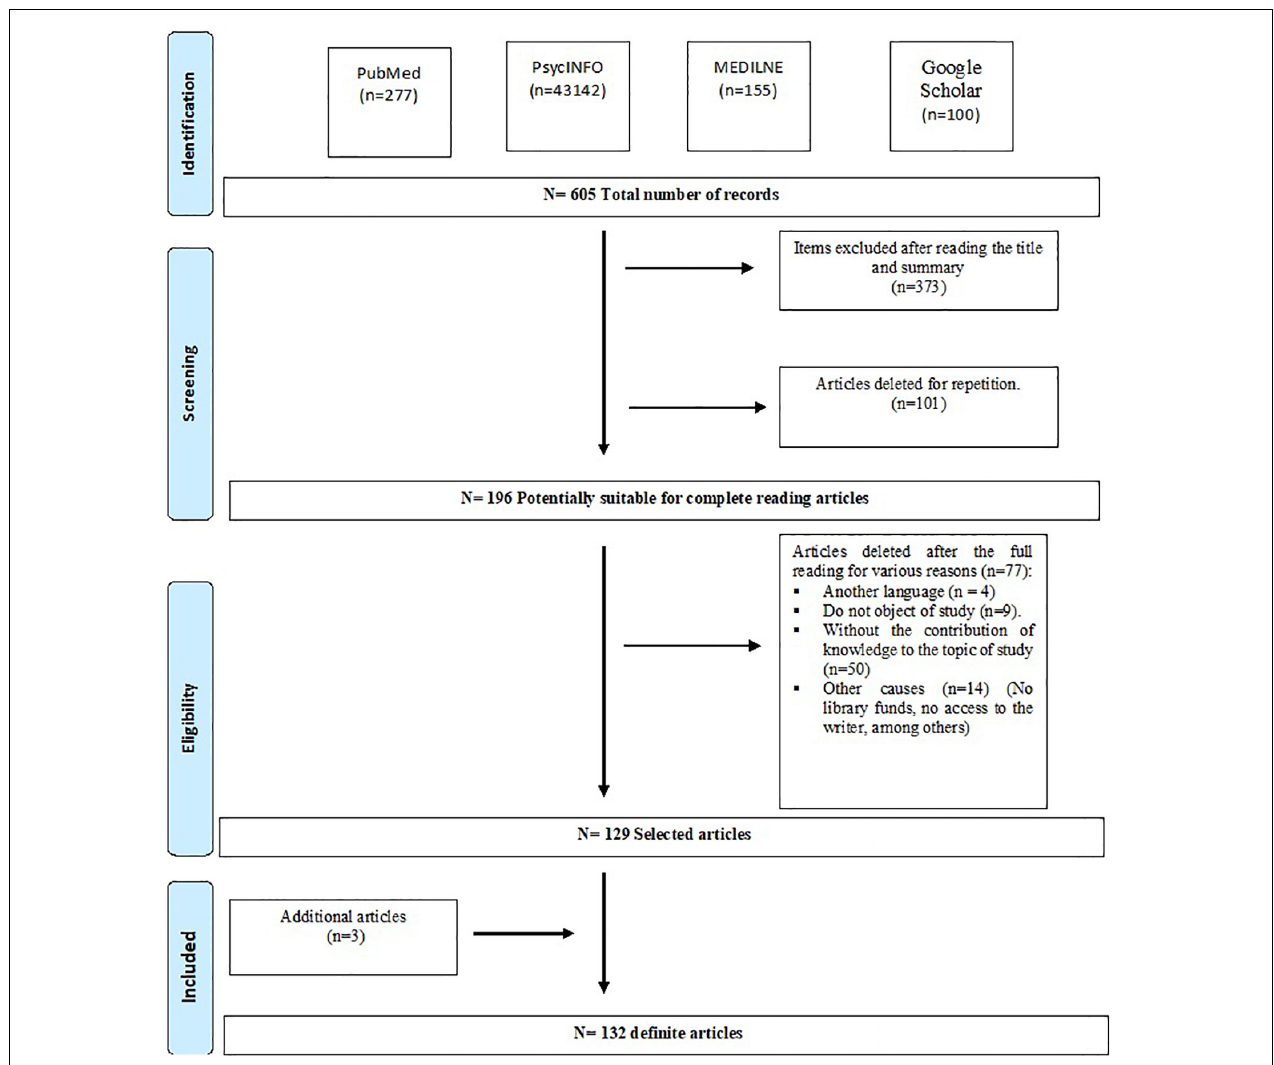
FIGURE 1 | Flowchart of the review following the PRISMA